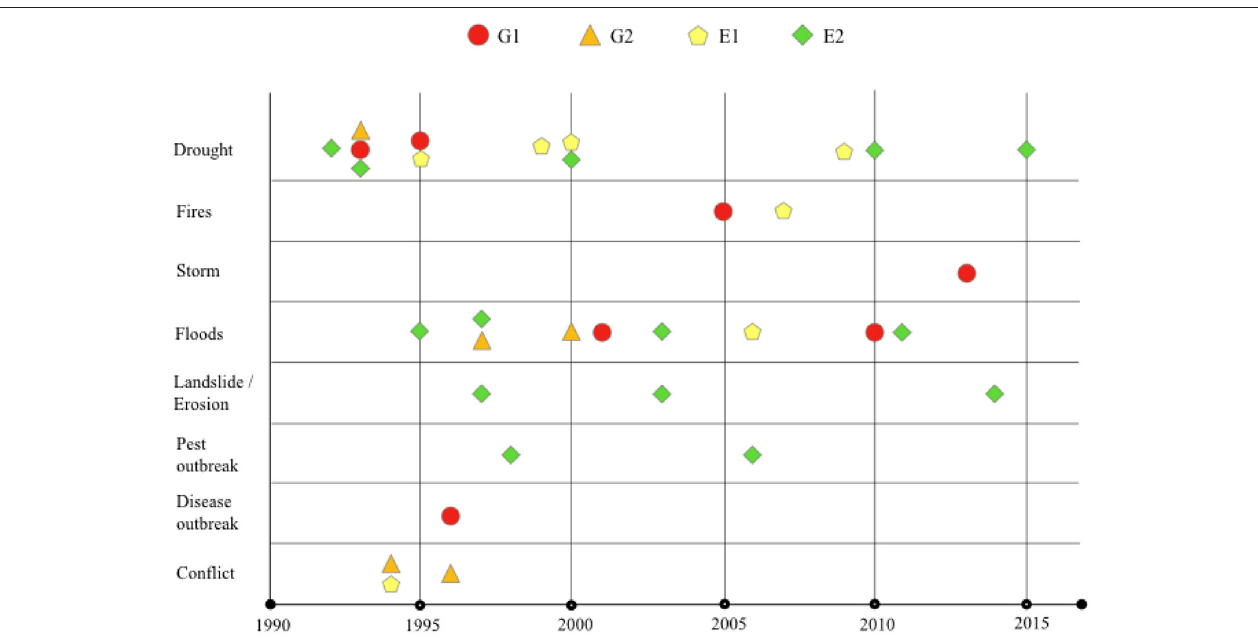
FIGURE 2 | Frequency and type of shocks and disturbances during the past 25 years (1990–2015) as recalled by the communities in the four watersheds during the consultative development of watershed action plans. Data drawn from Oguntunde et al. (2006), Debevec et al. (2016a,b), IWMI (2016b), and Amoah and Appoh (2017a,b).